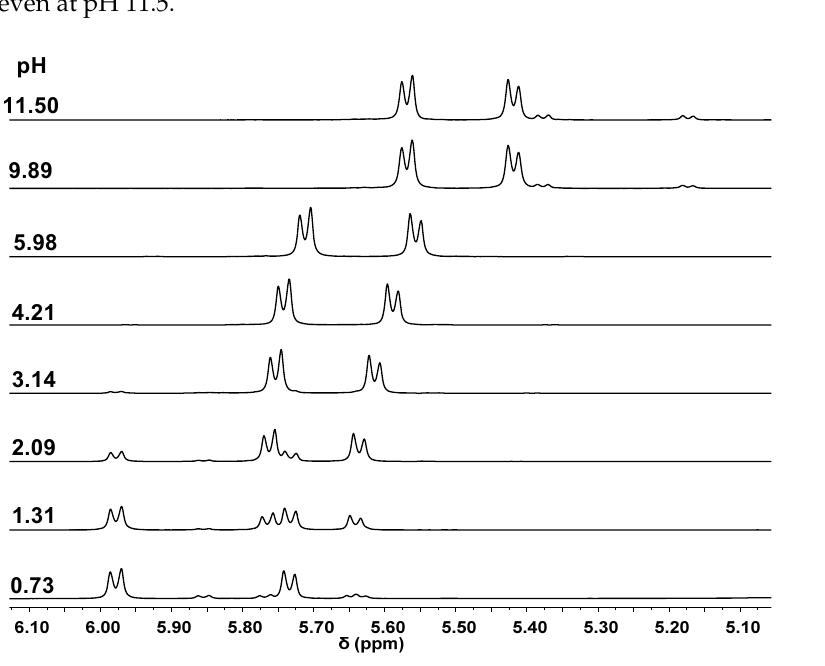
Figure 6. The pH-dependence of the 1 H NMR signals belonging to the neighboring ring protons of [( η 6 - p -cym)Ru] 2+ moiety registered with Ida2P 4 ‒ at a 1:1 ratio (c Ru = 10 mM, I = 0.20 M KNO 3 ).